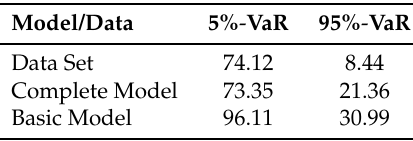
Figure 13. VaR for the ICE U.K. Natural Gas Futures estimated with the basic, but still cointegrated geometric model. Table 7. VaR of the different models and the real ICE U.K. Futures